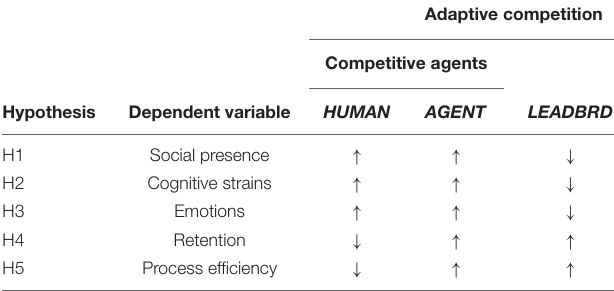
TABLE 1 | Study design and hypotheses.